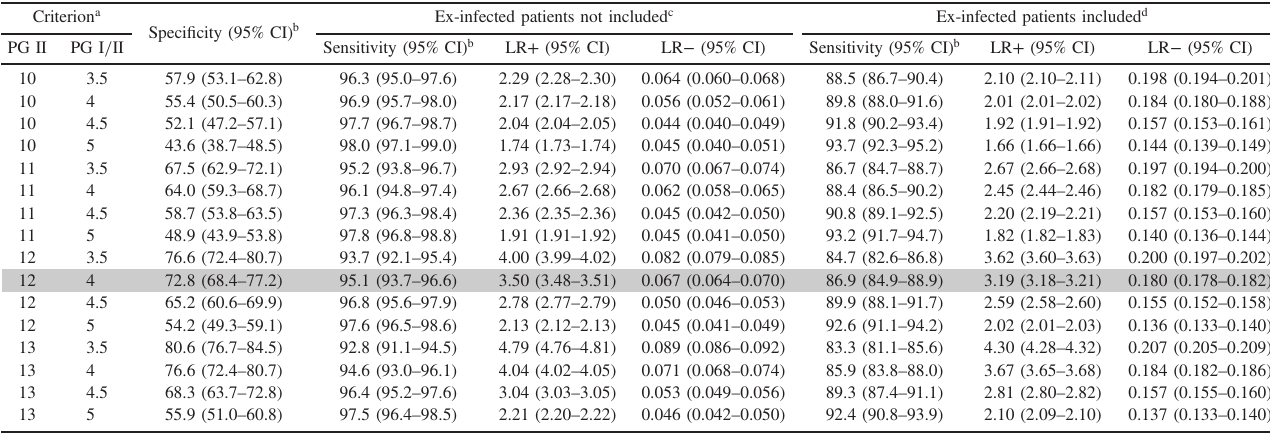
Table 5. Speci fi city and sensitivity for H. pylori infection under each criterion for measures obtained with the LA method Criterion